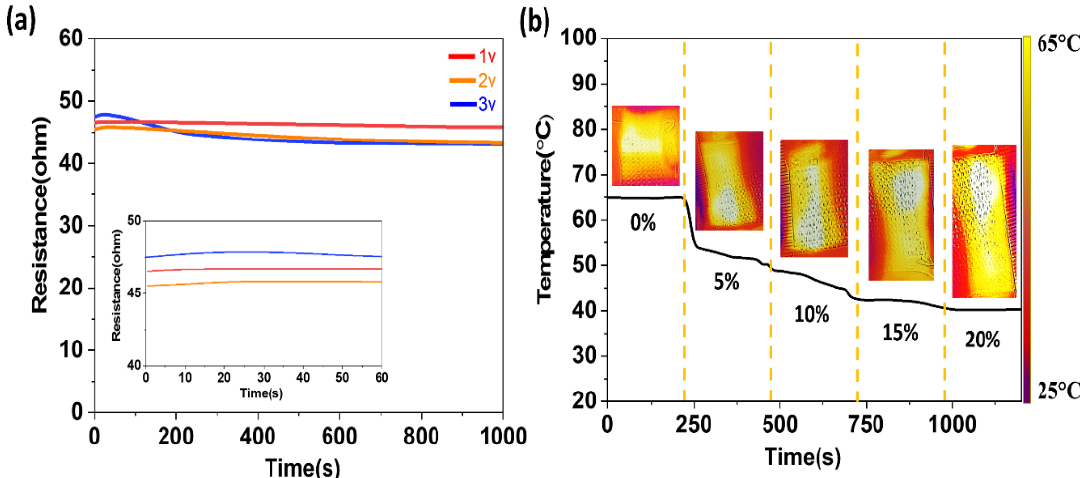
Figure 8. ( a ) Resistance of purl fabric under voltage values of 1 V, 2 V, and 3 V, ( b ) Temperature change under different strain forces (0–20%).